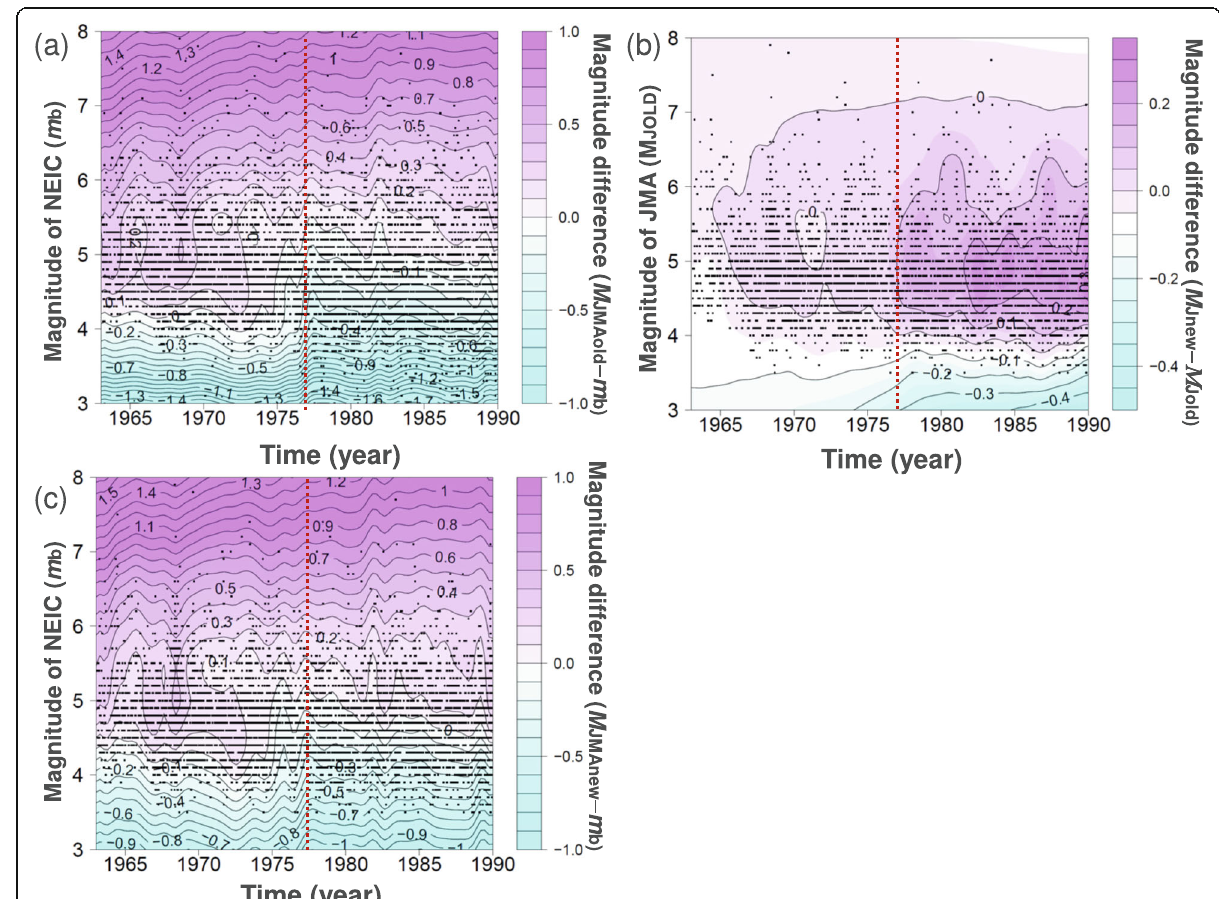
Fig. 1 Smoothed magnitude differences of earthquakes from JMA and USGS PDE catalogs from July 1965 – 1990 ( a , c ). The original version of the JMA catalog was revised in September 2004. The smoothed magnitude difference of earthquakes in the revised catalog and the original catalog is shown in panel b . Panel a compares the magnitude of the original JMA hypocenter catalog and c uses the revised JMA catalog. Contours show equidistance of 0.1 difference magnitude unit in the smoothed surface. Higher JMA magnitudes than USGS magnitudes are shown in purple. Light blue is used to show the opposite. The vertical red dotted line denotes 1977, when the significant change of the original JMA magnitude difference pattern in the range between m b 3.5 –